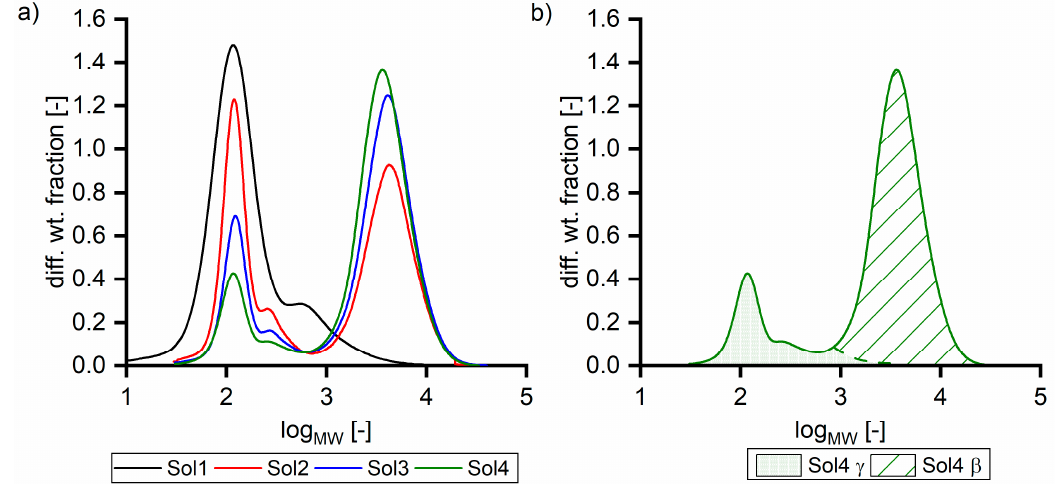
Figure 1 . Size exclusion chromatograms ( a ) of different solutions and ( b ) of Sol4 separated in β and γ fractions.